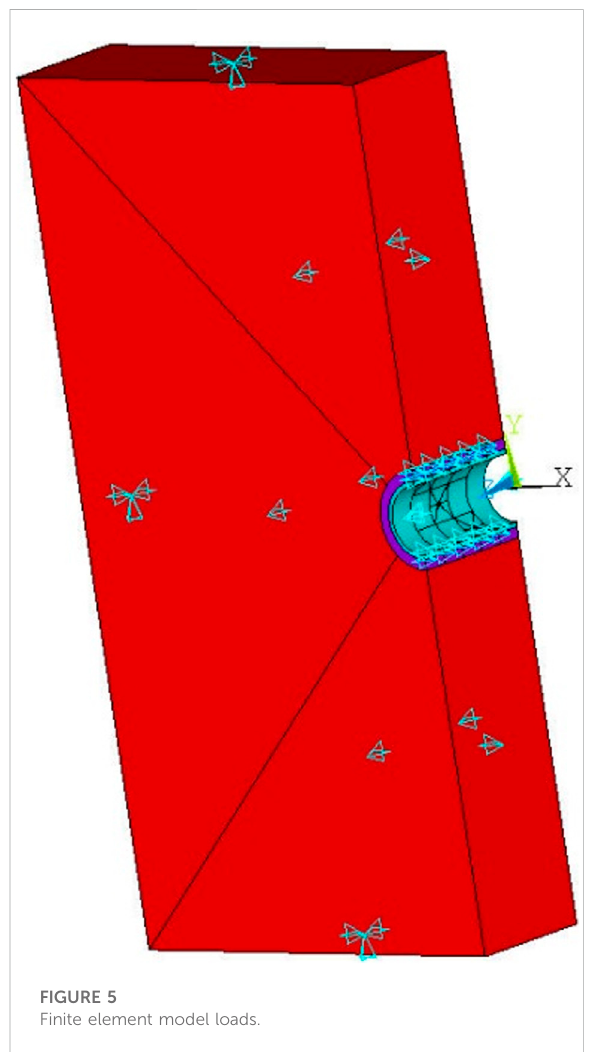
FIGURE 5 Finite element model